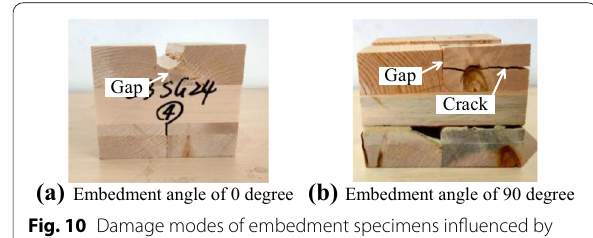
Fig. 10 Damage modes of embedment specimens influenced by the